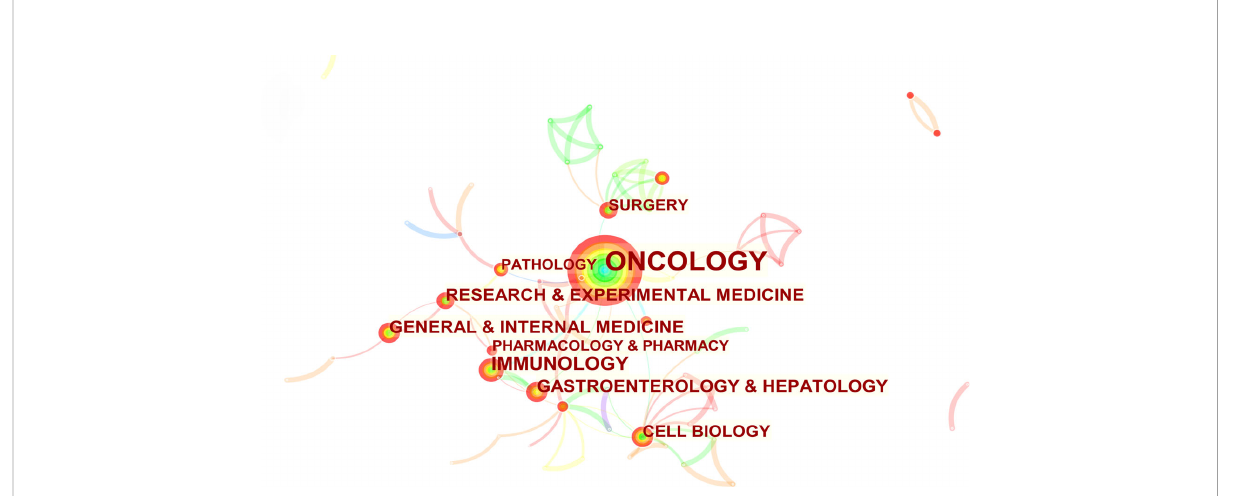
FIGURE 6 The visualization map of subject categories. The tree ring-shaped nodes represented different subject categories. The lines between two nodes meant co-occurrence. The area of the nodes referred to the number of publications. Nodes with high centrality were deemed as the hot fi